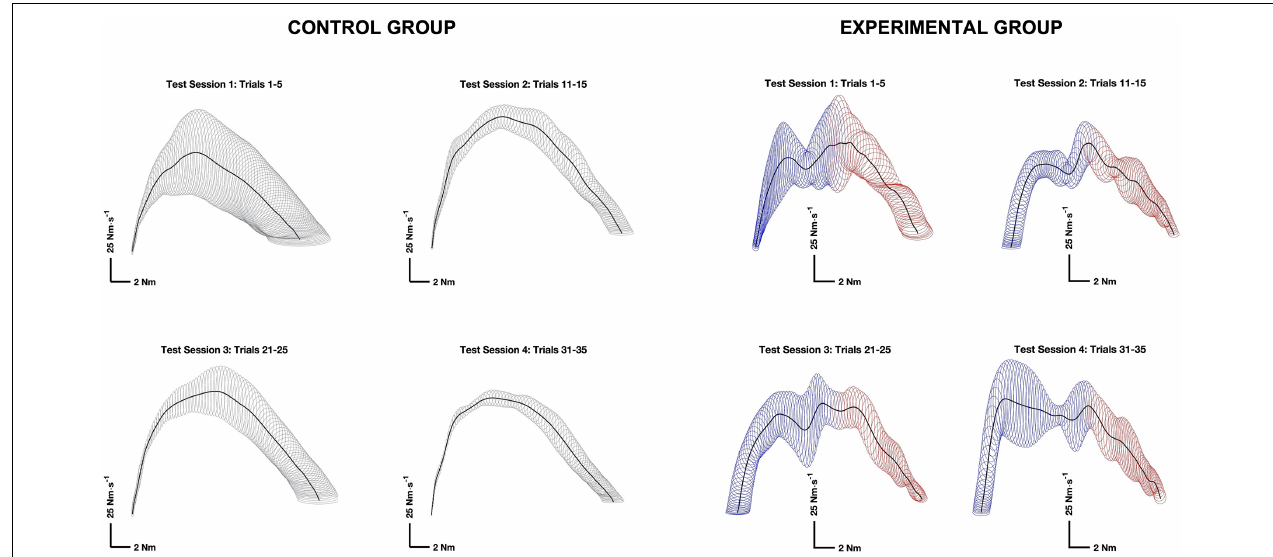
FIGURE 3 | Representative phase plane trajectories for the control (left) and experimental (right) groups. Phase plane trajectories (thick dark lines) were constructed by plotting the rate of torque ( y ) versus torque ( x ) , during the torque development phase of the contraction. The thin lines mapped onto the phase plane trajectories are variability ellipses with radii equal to one standard deviation in the rate of torque ( y ) and torque ( x ) directions. Maximal isometric flexion was initiated while the wrist was generating an extension torque and negative. The transition point between the negative torque in extension (blue) and a positive toque in flexion (red) in the experimental group is denoted by a transition in the color of the variability